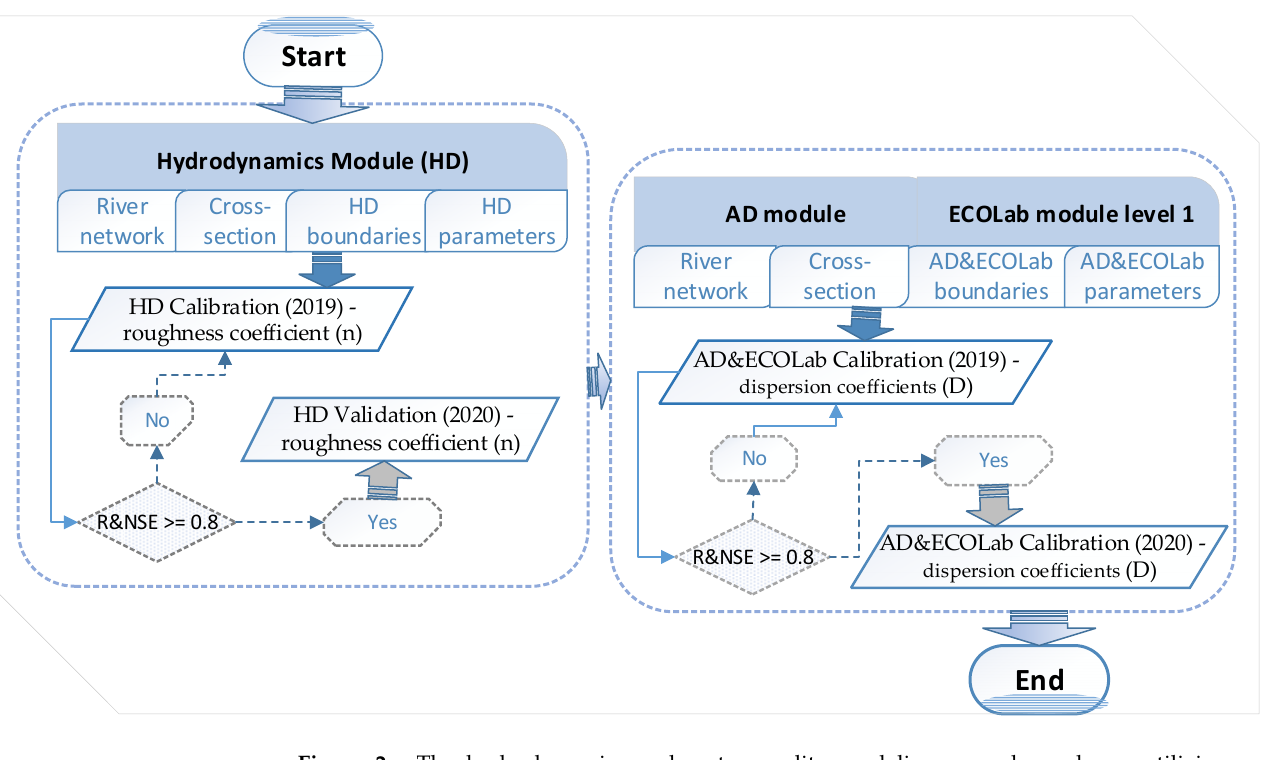
Figure 2. The hydrodynamics and water quality modeling procedure phases utilizing one-dimensional MIKE 11.